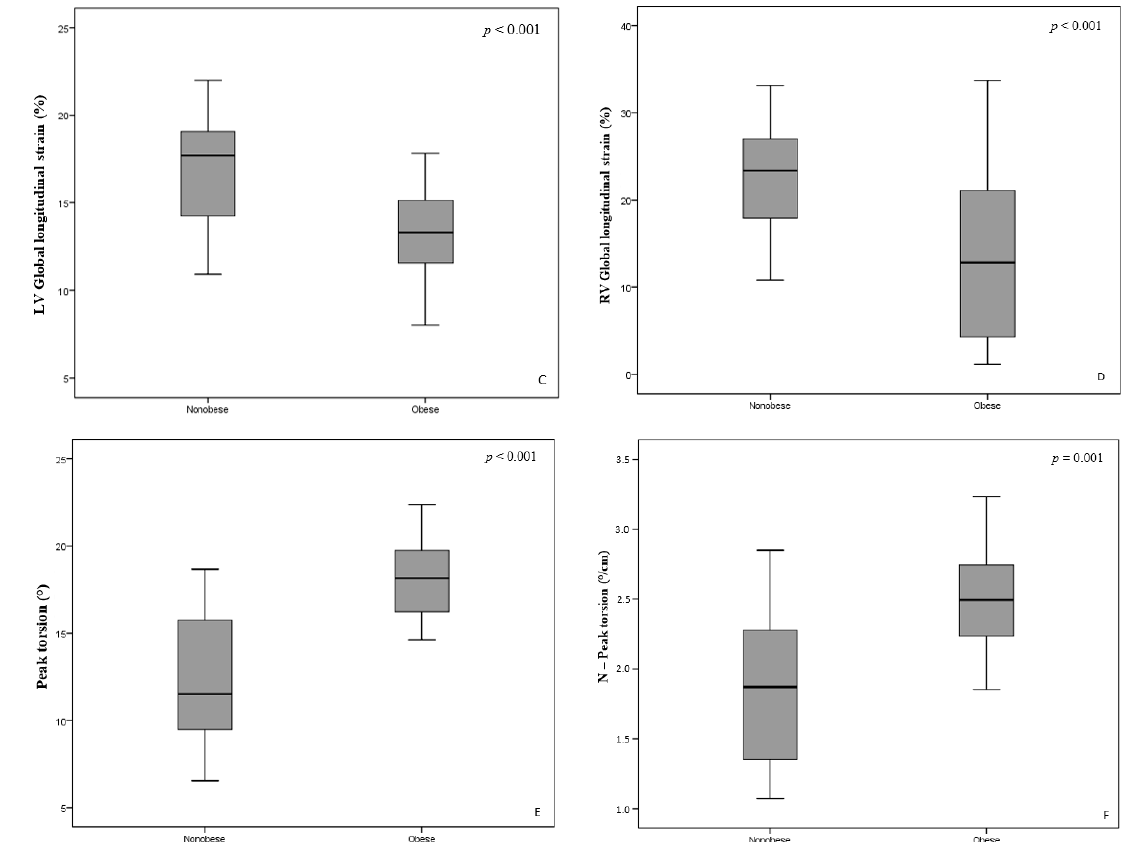
Figure 1. Comparison of the circumferential, radial strain of left ventricle ( A , B ) and longitudinal strain of left and right ventricle) ( C , D ), torsion, and normalized torsion of left ventricle ( E , F ) between obese and nonobese children.